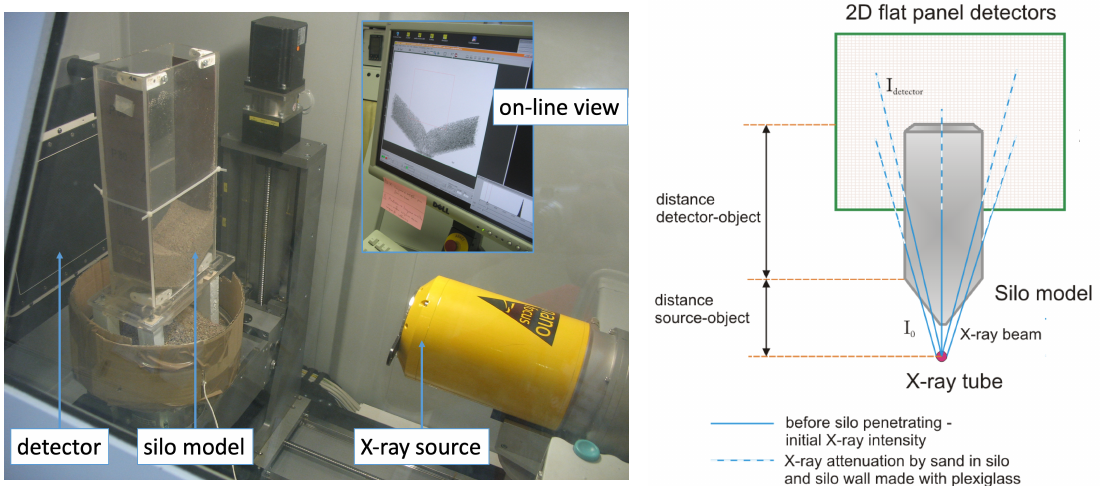
Figure 1. X-ray tomography imaging system: (left) photo of the silo model taken during X-ray scanning; panel detector on the far left, silo model on the left, X-ray tube on the lower right, and the corresponding online visualization included as an inset on the upper right; (right) schematic overview of the X-ray absorption model.